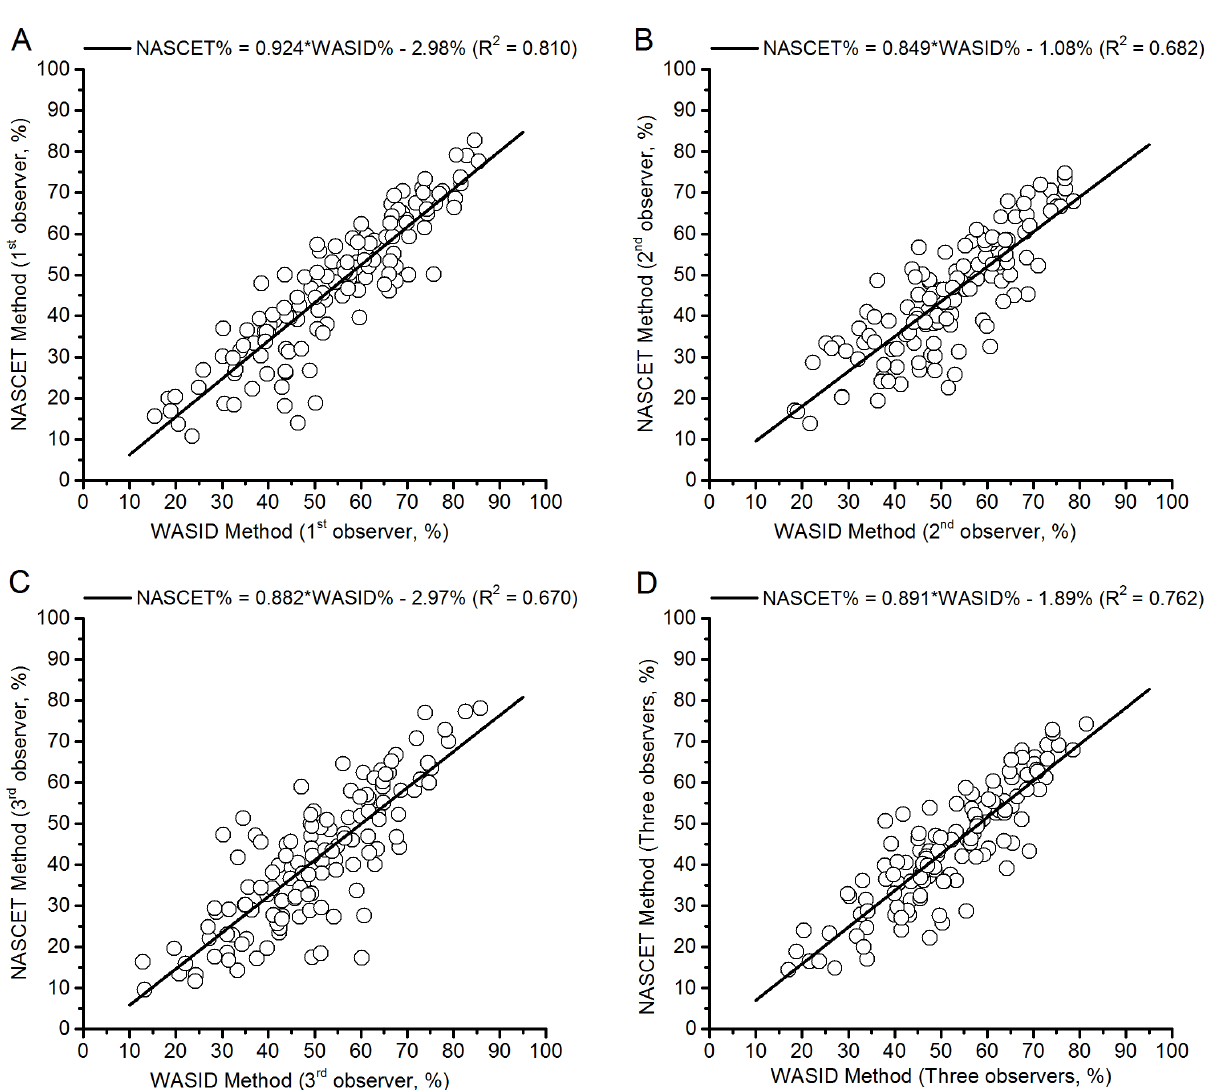
Fig 2. Scatterplots of NASCET and WASID measurements. (A) The measurements of Observer 1. (B) The measurements of Observer 2. (C) The measurements of Observer 3. (D) The mean measurements of all 3